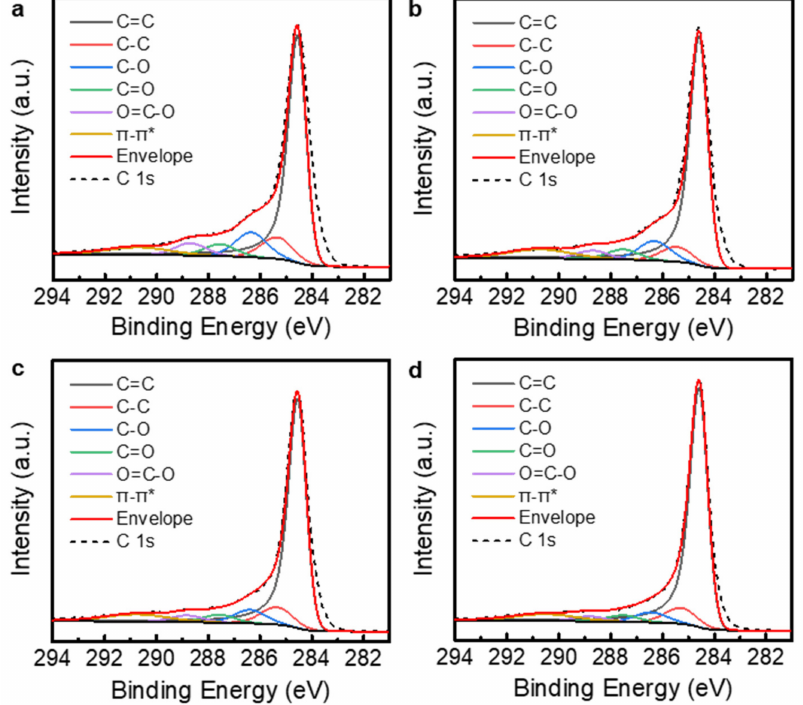
Figure 5. C 1s core-level XPS spectra of V-50 rGO powders. ( a ) As-received sample. ( b – d ) rGO powders additionally annealed at the temperatures of ( b ) 400, ( c ) 800, and ( d ) 1000 ◦